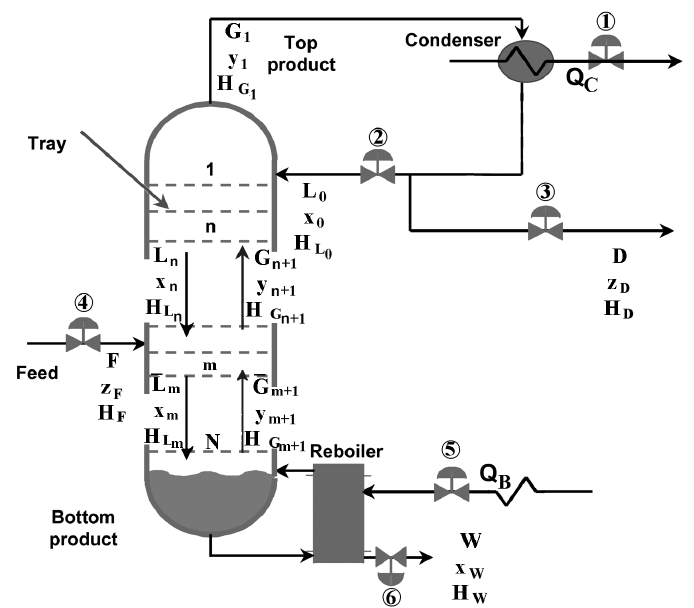
Figure 1. Schematic of distillation